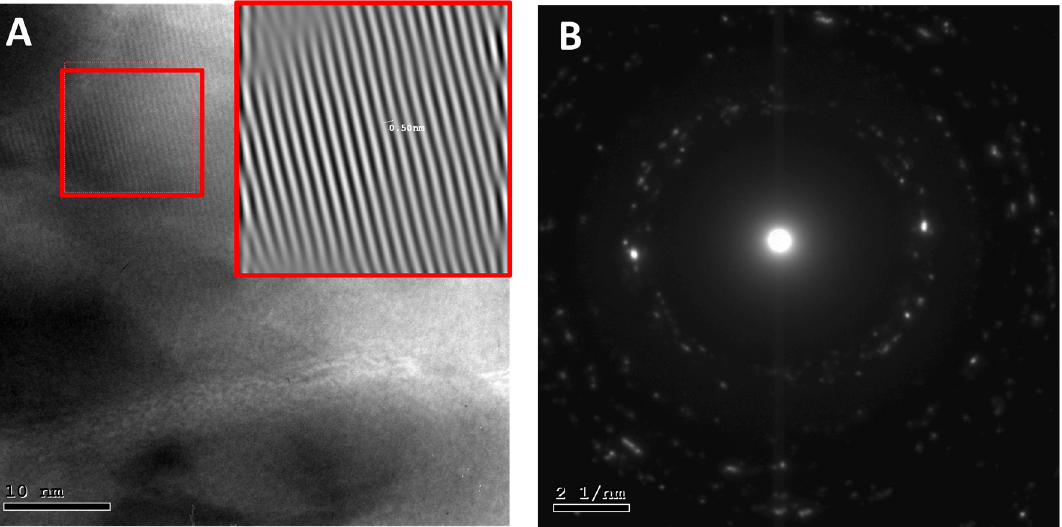
Figure 4. High-resolution TEM images ( A ) confirming the crystallinity of the generated particles using the green synthesis approach, ( B ) selected area diffraction (SAED) diffraction pattern of ZnO nanoparticles.